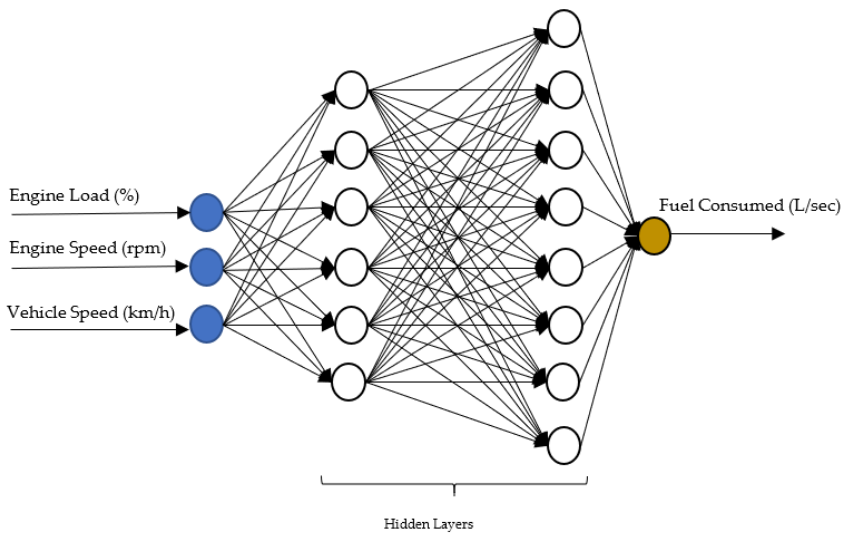
Figure 3. Artificial neural network structure.